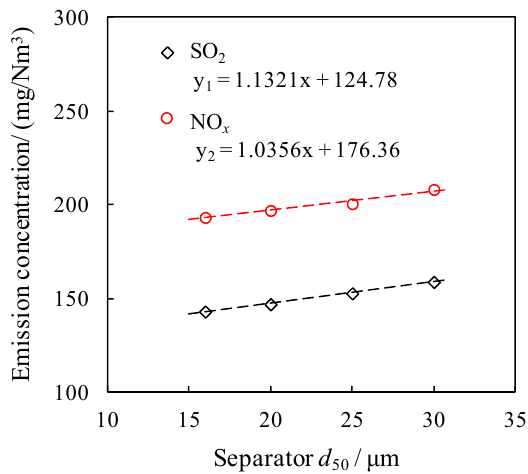
Figure 17. E ff ect of separator e ffi ciency on SO 2 and NO x emission. Figure 17. Effect of separator efficiency on SO 2 and NO x emission.